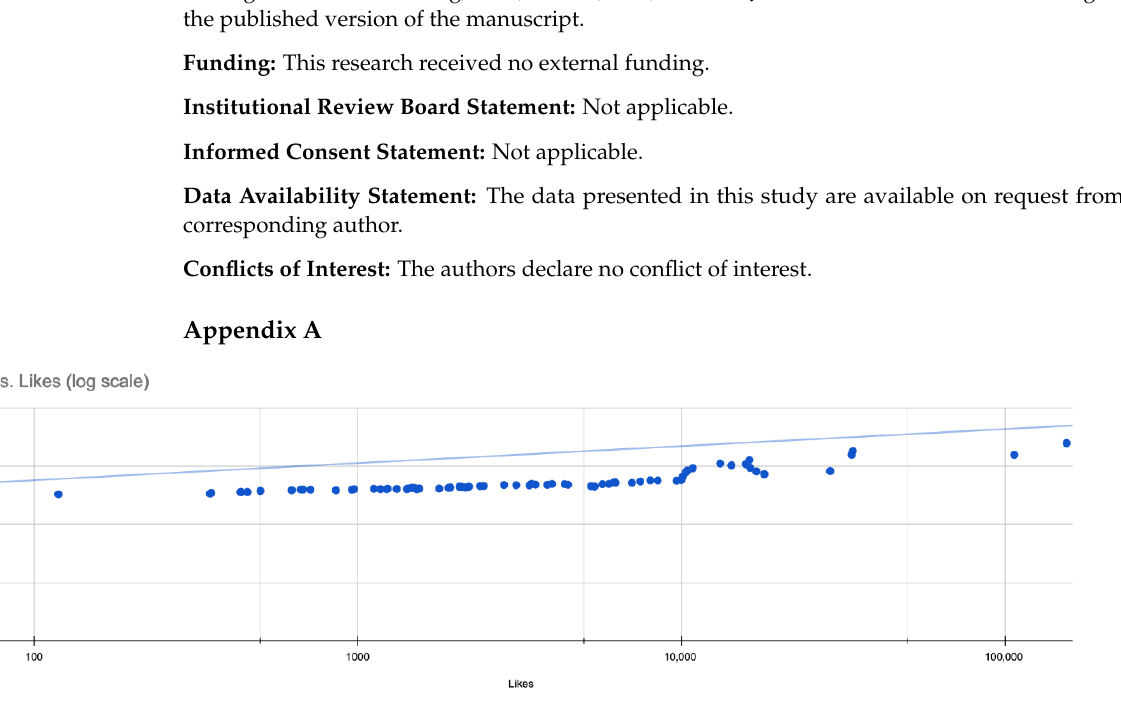
Figure A1. Likes were plotted on a log scale due to the typical distribution of this variable. When plotted against the GQS of the corresponding video, a positively sloped but almost horizontal line describes their relationship. This (non-)association seems to be statistically significant in a Spearman correlation (r = 0.29 [0.06; 0.49], p = 0.012). Note: the log-transformation of the “Likes” variable is done here for ease of viewing and does not change the outcome of (non-parametric) statistical analysis. Table A1. Fleiss’ Kappa estimated in order to assess rater agreement was determined to be poor in this data set both overall and for each individual value of